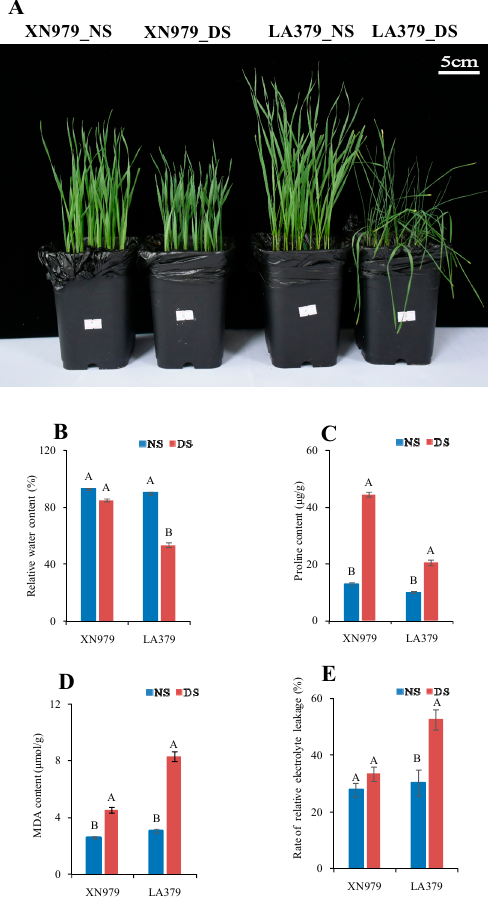
Figure 1. Phenotypic changes ( A ) and physiological responses ( B – E ) of XN979 and LA379 under drought stress (DS) and control (NS) conditions. ( A ) Phenotypic changes of XN979 and LA379 under drought stress (DS) and control (NS) conditions. ( B ) Relative water content (RWC); ( C ) Proline content; ( D ) malonaldehyde (MDA) content; ( E ) Rate of relative electrolyte leakage; NS, no stress; DS, drought stress. Three biological replicates were analyzed. Different letters indicate significant differences at P ≤ 0.01